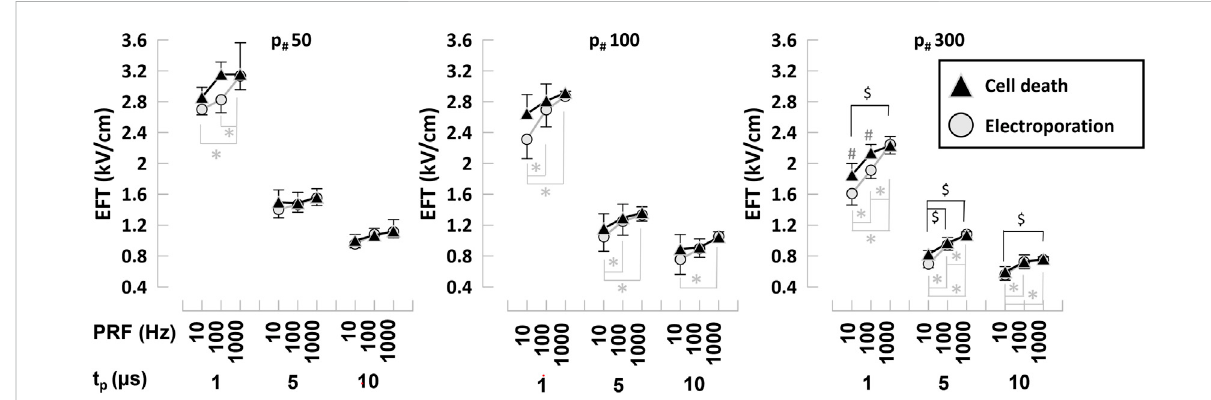
Electroporation and cell death EFTs for various PEF parameters in hiPSC-CMs. Electroporation and cell death EFTs for all the combinations of PEF parameters tested. Trains of 50, 100, and 300 pulses (left to right panels) and t p = 1, 5, and 10 µs were applied at PRF = 10, 100, and 1,000 Hz to hiPSC-CMs. EFTs were calculated from electroporation and cell death areas that were quanti fi ed from the borders of YP1 and PI uptake 30 min and 4 h after PEF treatments, respectively. See text for more details. The error bars represent the standard error (95% con fi dence interval) for a sample size of n = 3 – 8 for all data points, * ,$,# p < .05,where * indicates the statistical analysis for electroporation,$ for cell death and # the statistical analysis comparing electroporation and cell